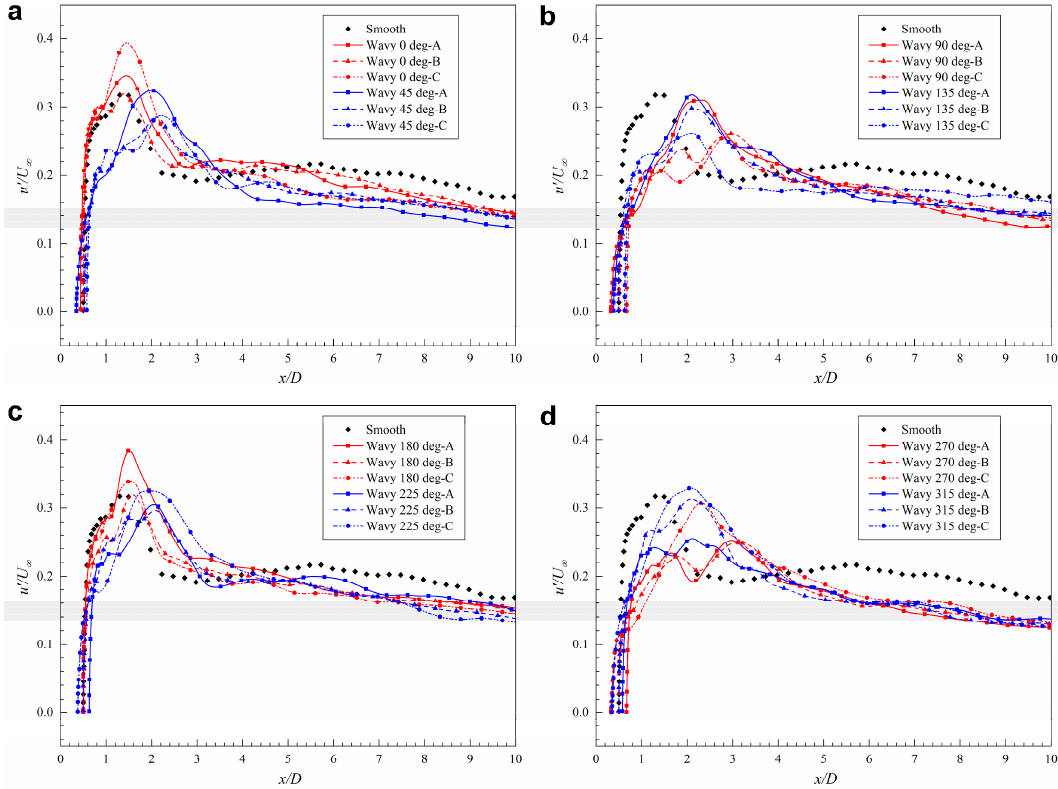
Figure 7. Comparison of the r.m.s. streamwise velocity distributions of the smooth cylinder and wavy cylinder A1 at eight rotation angles. Here, ( a ) θ = 0° and 45°; ( b ) θ = 90° and 135°; ( c ) θ = 180° and 225°; ( d ) θ = 270° and 315°.